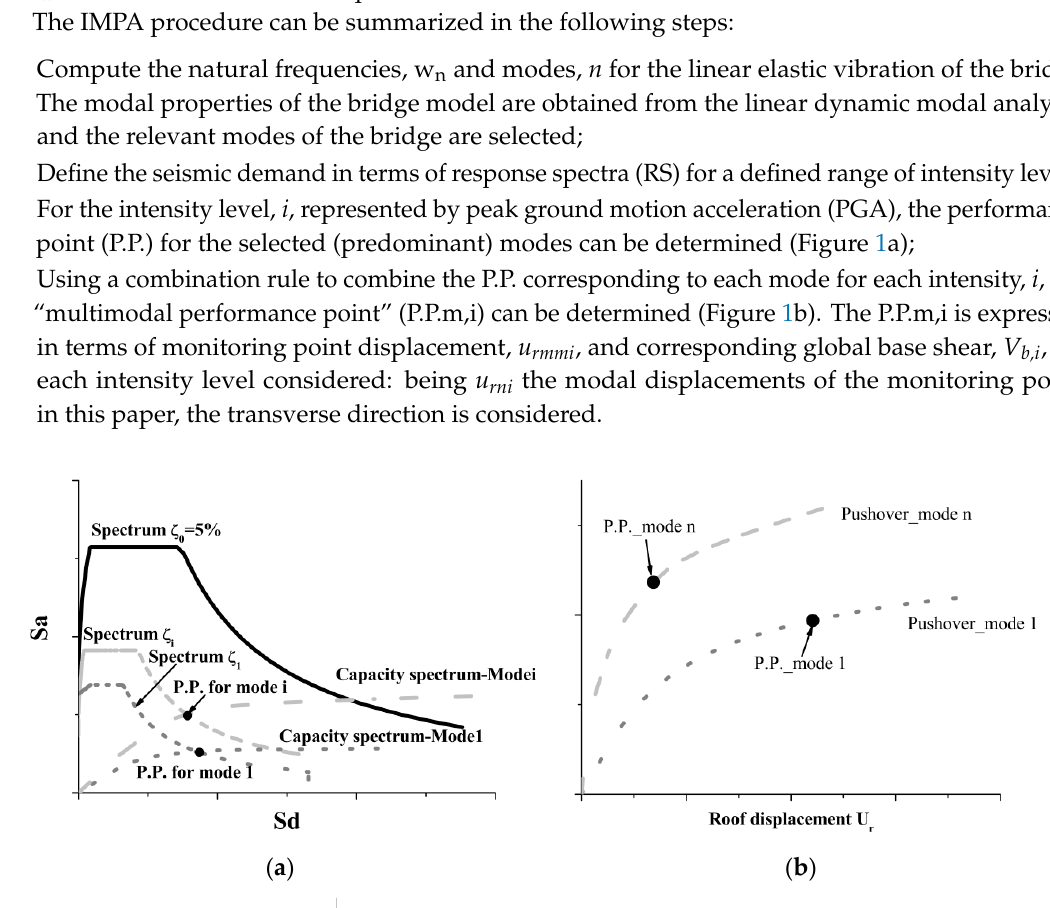
Figure 2. Degree of freedom of the bridge: by performing the NSA, the displacement u r of the monitoring point is controlled. In this work, u r is the transversal displacement. Figure 3. Application of the Square Root of the Sum of Squares rule to a bridge. From the applications performed on the two cases of study (regular and irregular bridges, presented in Section 3.1), it is demonstrated that, specifically for the case of an irregular bridge, better results can be achieved if both the modal pushover and a uniform pushover analysis (UPA) are performed. Therefore, IMPA β requires us to perform IMPA (the incremental MPA) and IUPA (the incremental UPA), and afterward to derive an univocal capacity curve from an envelope; the IMPA β capacity curve is defined connecting, for each intensity step i , the performance point P i,IMPA β defined in (4) and described in Figure 4. P i,IMPA β = (max (u r,i,MPA ;u r,i,UPA ); max (V b,i,MPA ;V b,i,UPA )) (4) where (u r,i,MPA; V b,i,MPA ) and (u r,i,UPA; V b,i,UPA ) are the coordinates of the performance point for the intensity, i , obtained by performing MPA or UPA. The flowchart of this new procedure is displayed in Figure 5. The seismic demand is expressed in terms of the Response Spectrum (RS): An RS can be selected for the site of the bridge, and then it can be linearly scaled to cover the desired intensity range. Otherwise, the scaling procedure can be performed by acting on the return period (Tr), obtaining different spectra for different intensities. A third possibility is to derive the RS from a set of ground motions (GMs), generated or selected by investigating the local seismicity for each intensity level.